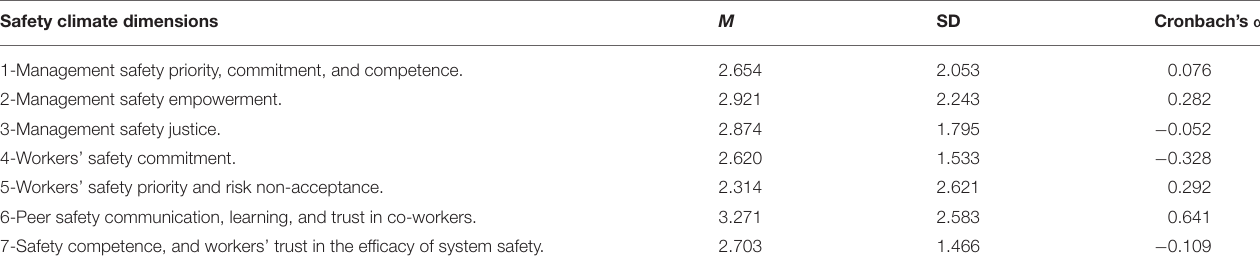
TABLE 3 | The mean perception of safety climate among the workers in the second industrial city – Dammam. Safety climate